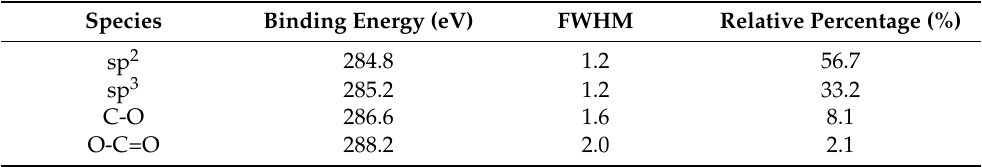
Figure 10. C1s X-ray photoelectron spectroscopy (XPS) spectrum with peak deconvolution for ground DLC specimen. Table 7. Binding energies of the species and corresponding relative percentages, FWHM = full width at half